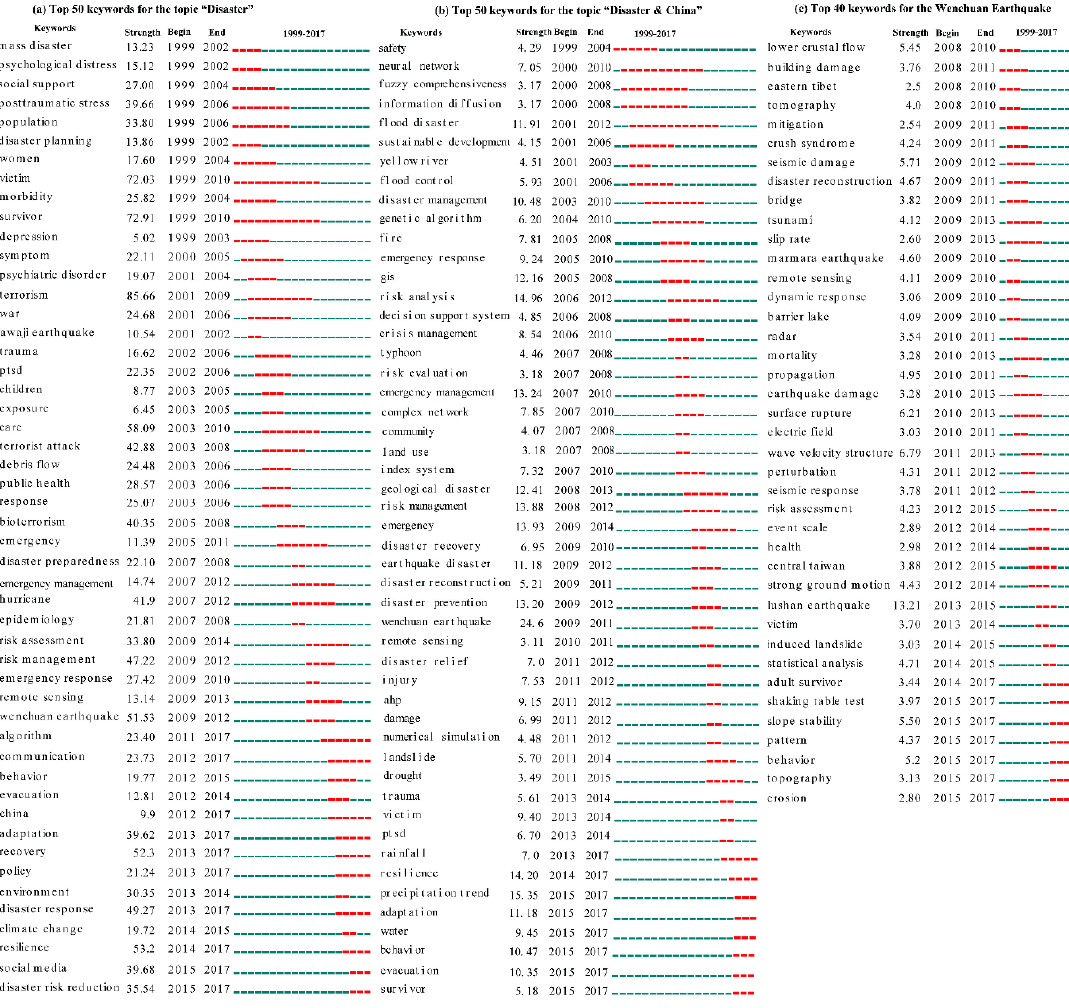
Figure 5 . Important keywords with the strongest bursts. Figure 5. Important keywords with the strongest